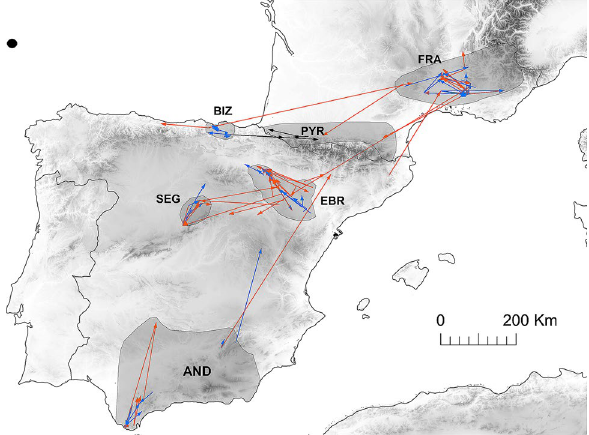
Figure 1. Euclidean distances between the natal and the first-breeding site of Egyptian vultures in Spain and France. Blue: males; Orange: females; Black: non-sexed birds. The distribution of the study populations is also shown. AND Andalusia, BIZ Bizkaia, EBR Ebro Valley, FRA France Southeast, PYR France Pyrenees, SEG Segovia. The background map was generated by DS modifying and assembling the digital elevation models available at the Copernicus Land Monitoring Service (https ://land.coper nicus .eu/image ry-in-situ/eu-dem), using ArcGIS 10.2 (https ://www.esri.com/en-us/arcgi s).